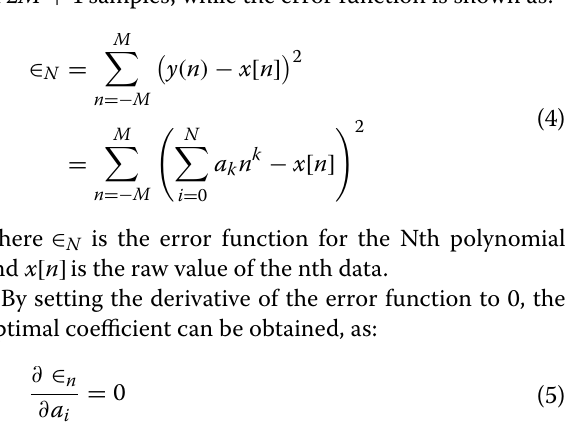
Fig. 3 Aging mechanism of lithium battery. Reprinted with permission from [46]. Copyright 2016, Elsevier